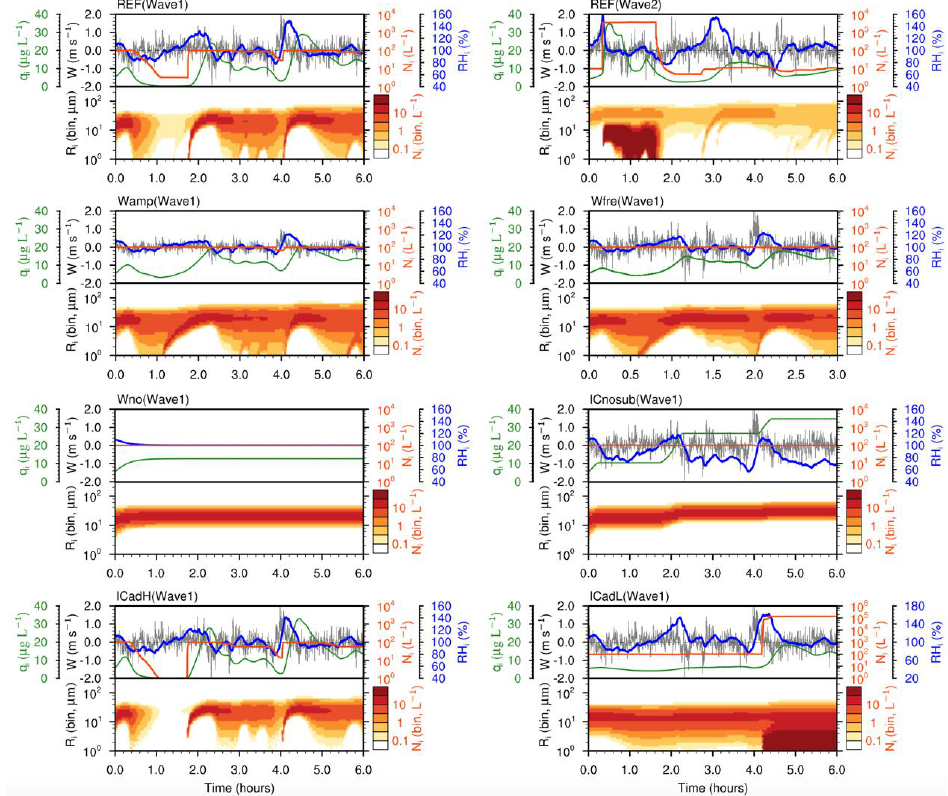
Figure 2. Cirrus evolutions from parcel model simulations using the W time series shown in Figure 1 (Wave1 or Wave2). Shown are RH i (blue thick solid line), W (gray thin solid line), N i (orange thin solid line), q i (green thin solid line). Black dotted line represents the line of W = 0, also the line of RH i = 100%. The shaded figures indicate the N i contribution from each radius bin. A total of 50 bins were used in this study. Experiment names and the corresponding W time series are marked in the upper left corners. Note that the ranges of the N i -axis and RH i -axis from the ICadL experiment are different from the others.